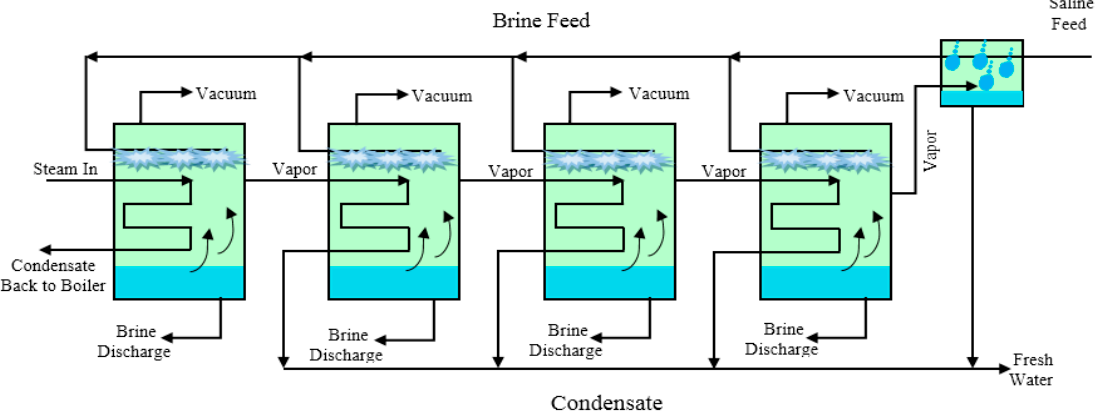
Figure 3. A schematic diagram of MED seawater desalination plant.